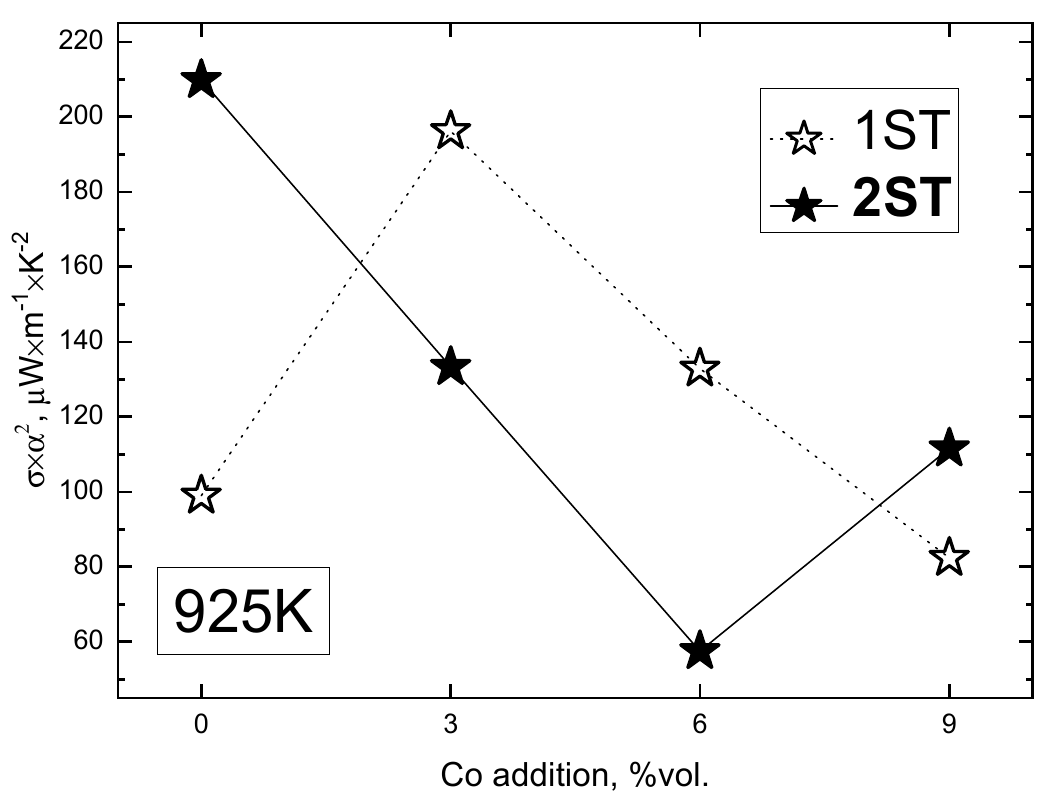
Figure 7. Compositional dependence of the power factor at 925 K, for the 1ST and 2ST sintered samples.